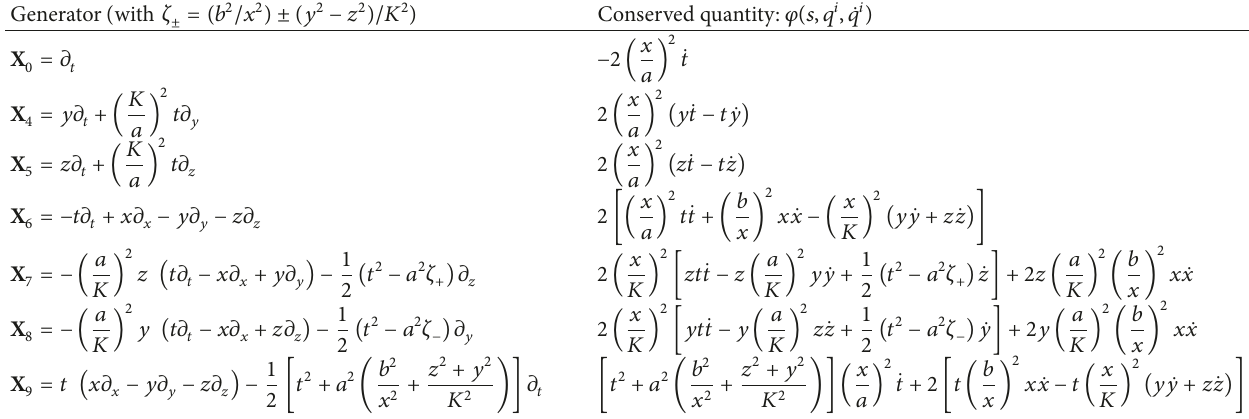
Table 4: Conserved quantities corresponding to each Noether symmetry.